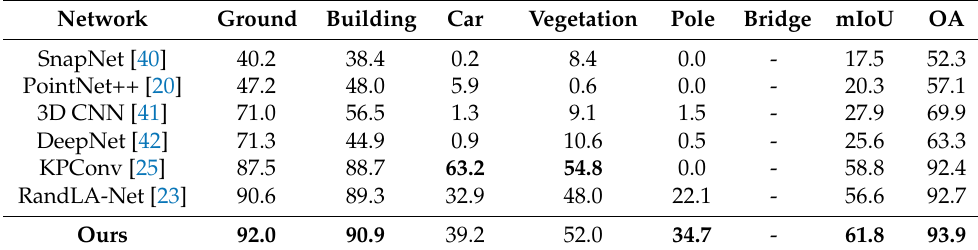
Table 4. The segmentation results evaluated on IoU of each category, mIoU, and OA in scene-5 of the CSPC.